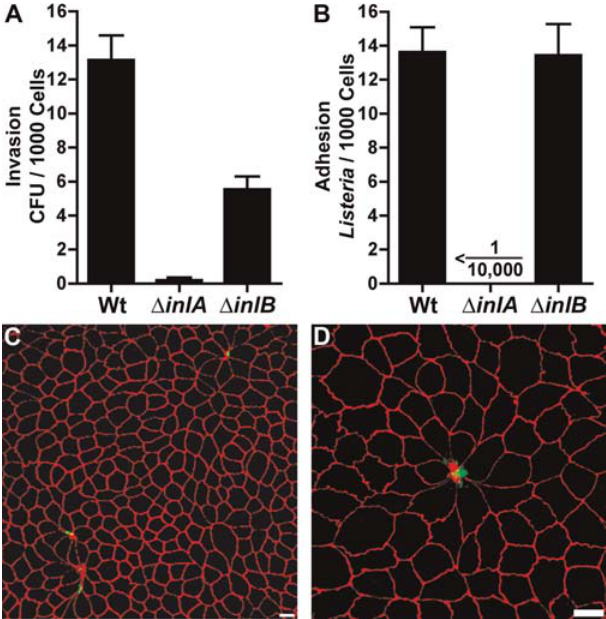
Figure 2. Internalin A–Dependent Apical Adhesion and Invasion of Polarized Epithelia (A and B) Polarized MDCK monolayers were infected from the apical side with Wt, D inlA, or D inlB L. monocytogenes . (A) Invasion was determined by quantification of viable CFUs of intracellular bacteria after gentamicin treatment. Means and standard